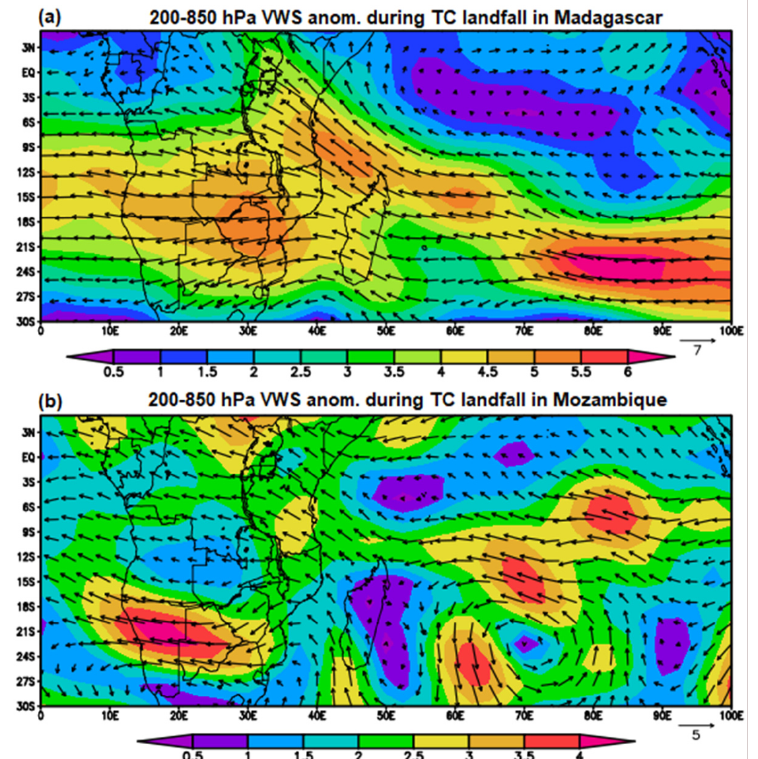
Figure 9. Composite anomalies of December–March 200–850 hPa VWS associated wind landfall over Madagascar west coast ( a ) and Mozambique coast ( b